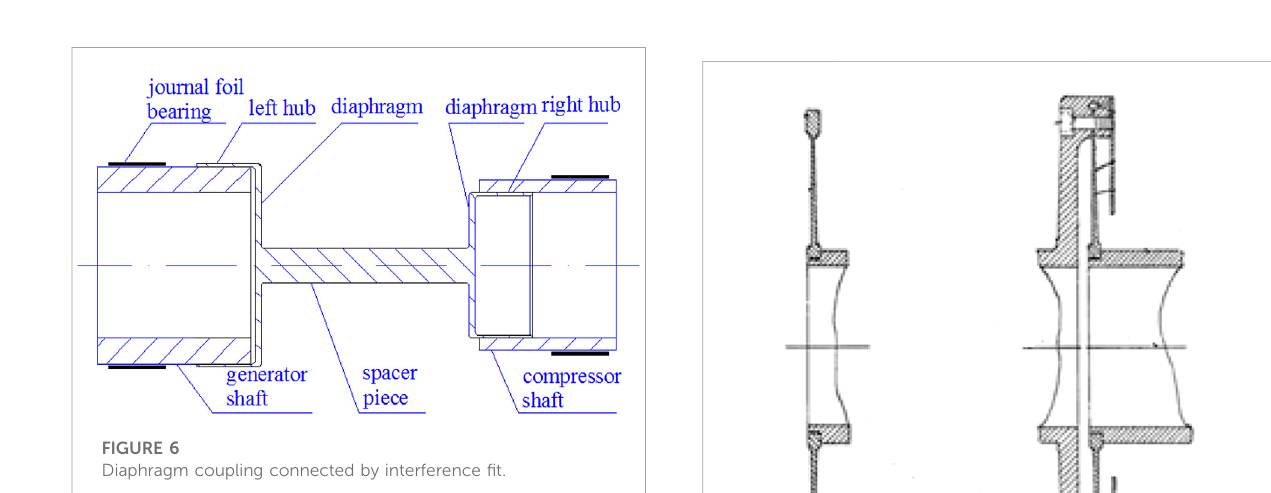
FIGURE 5 Multiple membrane diaphragm coupling.